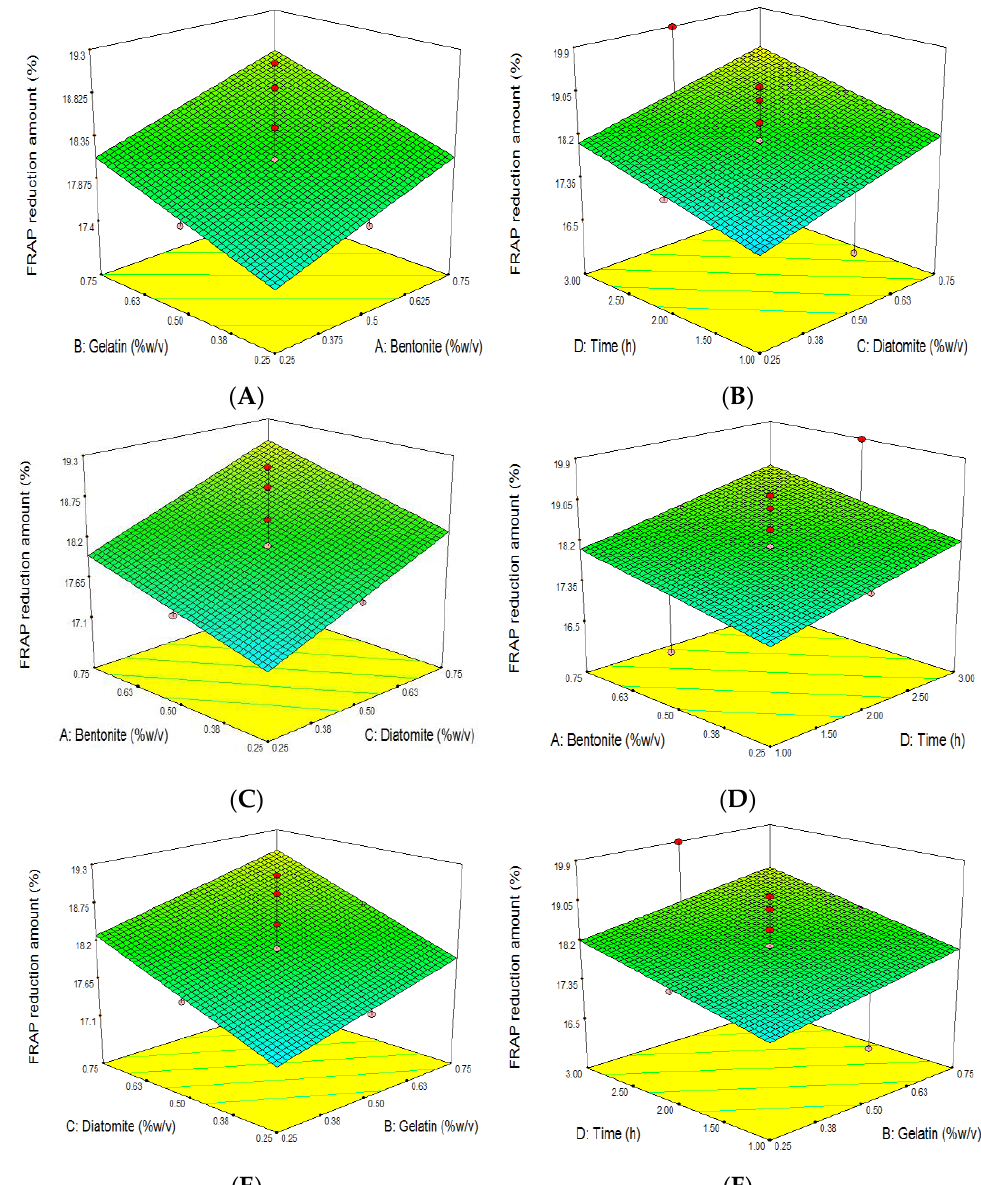
Figure 4. Response surface plot of the effects of bentonite, gelatin, and diatomite concentration and clarifying time on grape juice ’ s antioxidant capacity reduction amount (%). Influence of ( A) : gelatin and bentonite, ( B) : diatomite and bentonite, ( C) : time and bentonite, ( D) : diatomite and gelatin, ( E ): time and gelatin, ( F) : time and diatomite, on grape juice’s antioxidant capacity reduction amount (%).